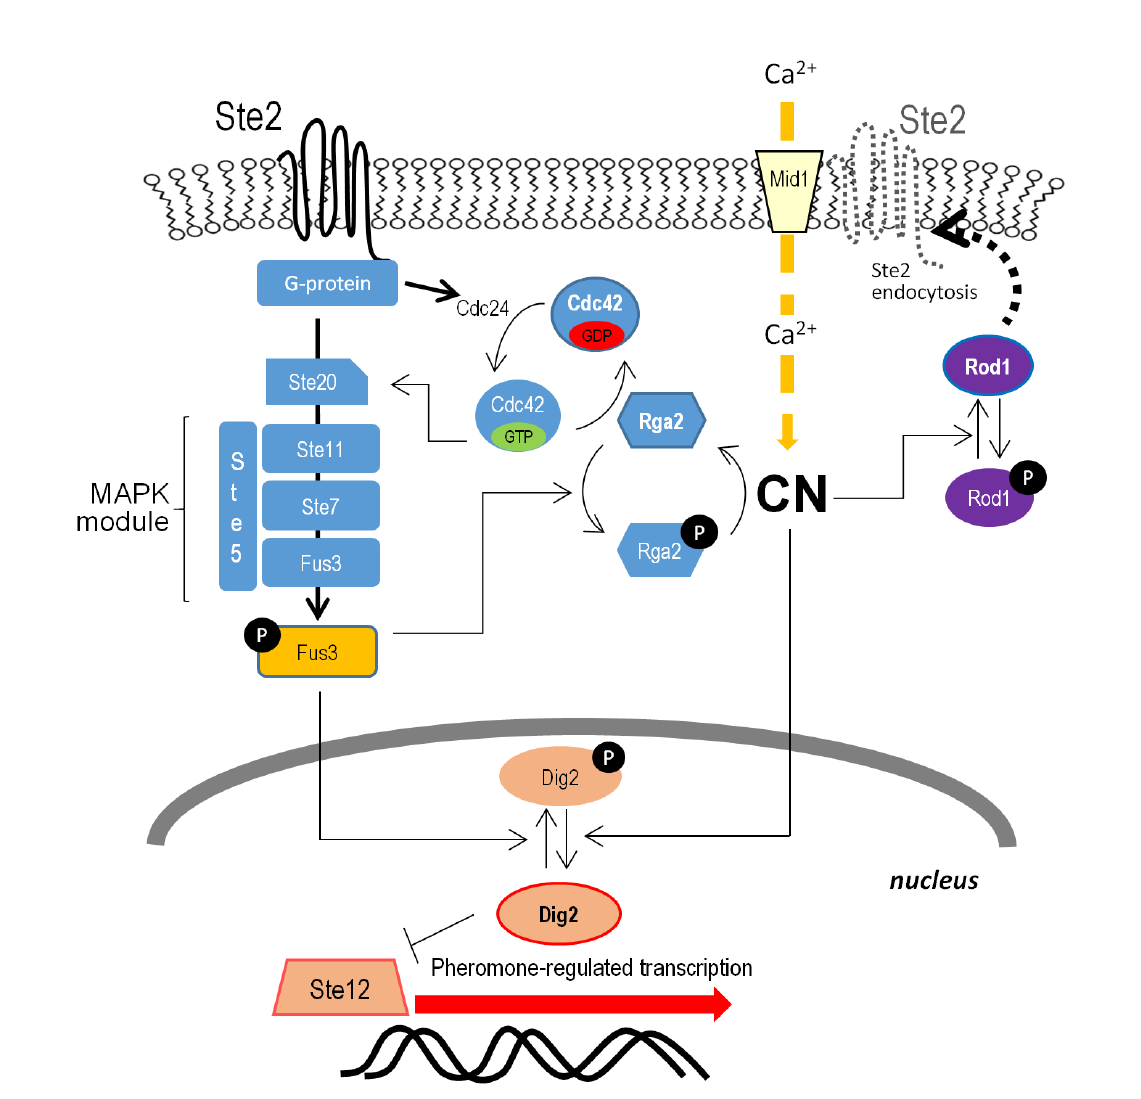
FIGURE 12: Roles of calcineurin during pheromone response. Upon stimulation with pheromone (α -factor in the model) entry of calci- um promotes activation of calcineurin. To attenuate pheromone signaling, calcineurin acts at least at three levels: a) dephosphorylates Rod1 to promote endocytosis of the pheromone receptor; b) dephosphorylates Rga2, leading to decrease in Cdc42-GTP levels and at- tenuation of signaling through the Fus3 MAP kinase module; c) dephosphorylation and activation of the Ste12 inhibitor Dig2, to de- crease pheromone-regulated specific gene transcription. Other targets downstream Fus3 are not included for OPEN ACCESS | www.microbialcell.com 239 Microbial Cell | MAY 2019 | Vol. 6 No. 5